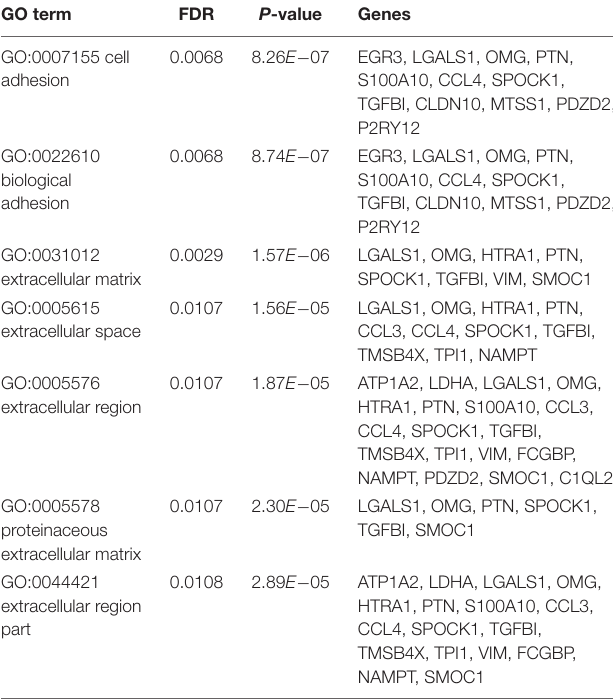
TABLE 3 | The GO enrichment results of the 31 selected genes.